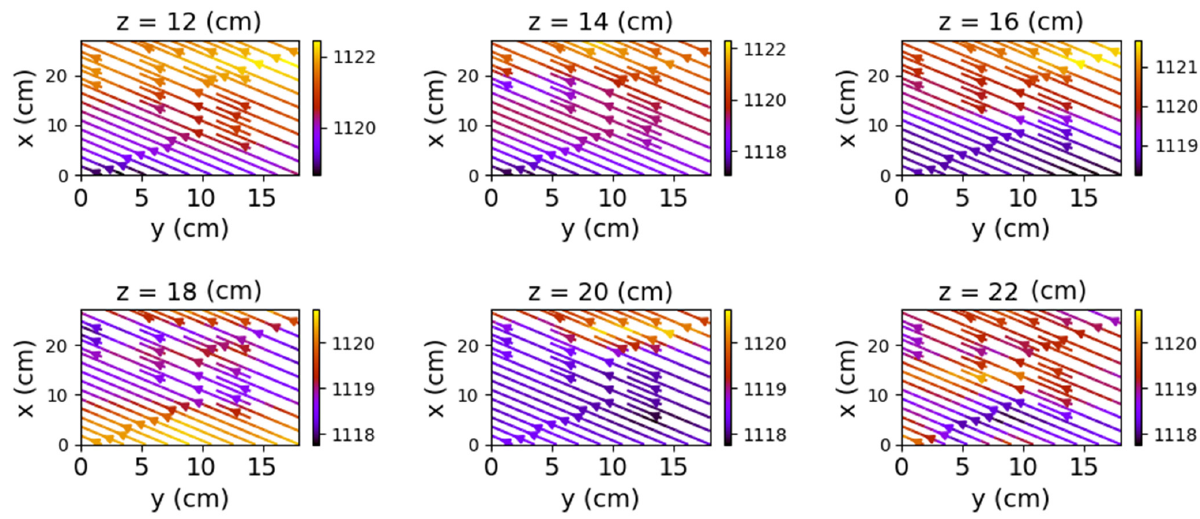
Figure 14. Field lines for x O y plane—relay with both coils powered.